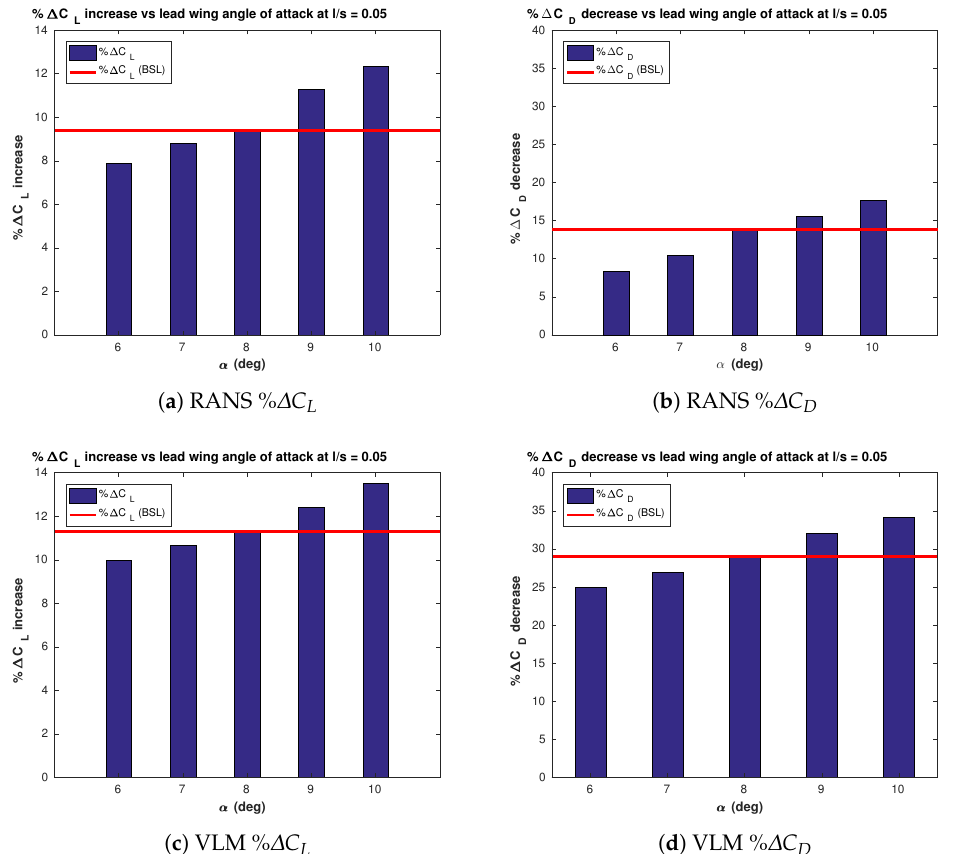
Figure 11. Effect of lead wing’s AOA on aerodynamic coefficients of trail wing with red line corresponding to Baseline Configuration (Both wings AOA = 8): ( a ) percentage lift coefficient (% ∆ C L ) for RANS; ( b ) percentage drag coefficient (% ∆ C D ) for RANS; ( c ) percentage lift coefficient (% ∆ C L ) for VLM; and ( d ) percentage drag coefficient (% ∆ C D ) for